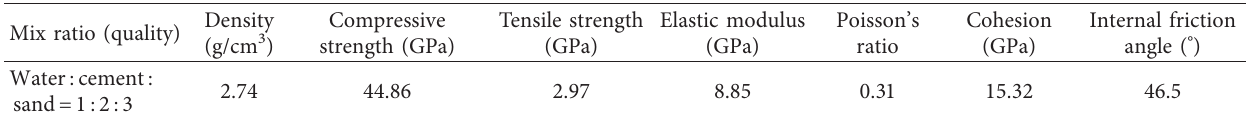
Figure 4: Specimen preparation process [38]. (a) Making a joint model. (b) Pouring specimen. (c) Model maintenance. (d) Model preparation completed. Table 1: Mechanical parameters of rock-like materials used.